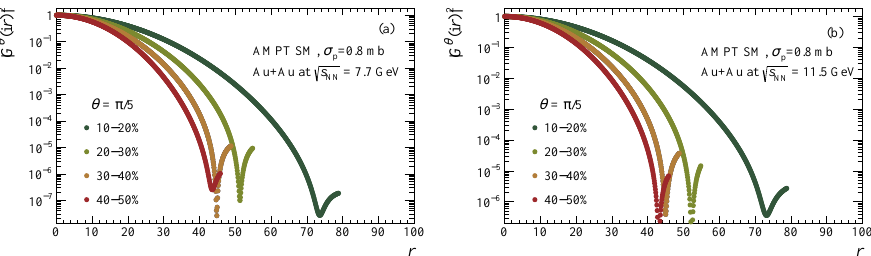
Figure 1. Squared modulus of the second harmonic product generating function | G θ ( i r ) | 2 of Lee– Yang zeros method as a function of r for θ = π /5 for four centrality classes from Au+Au collisions at √ s NN = 7.7 ( a ) and 11.5 GeV ( b ) using AMPT SM